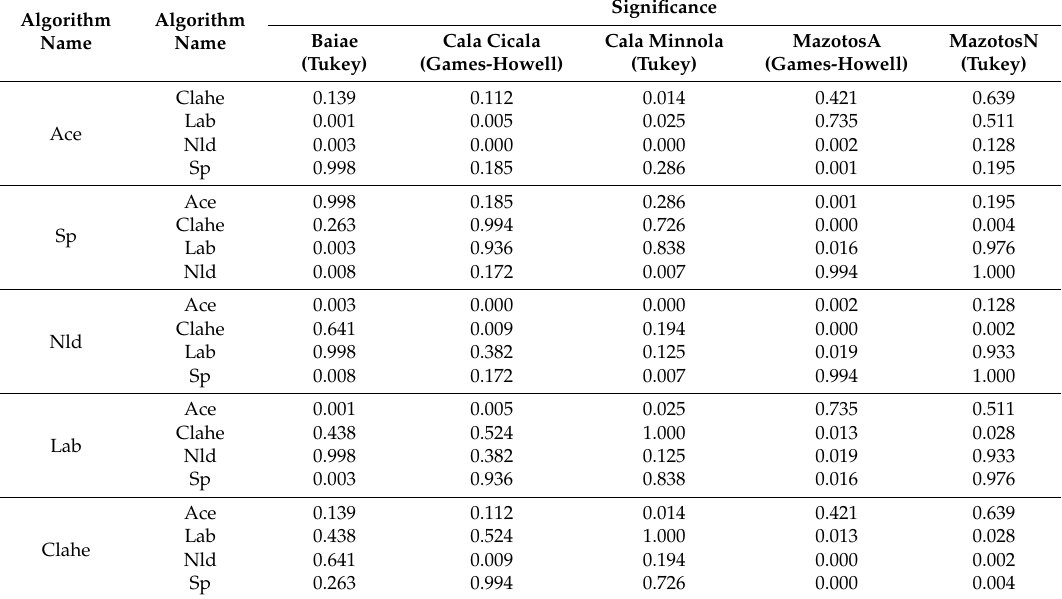
Table 9. “Post hoc” analysis performed on all sites. In parentheses, the “post hoc” test employed on each site is